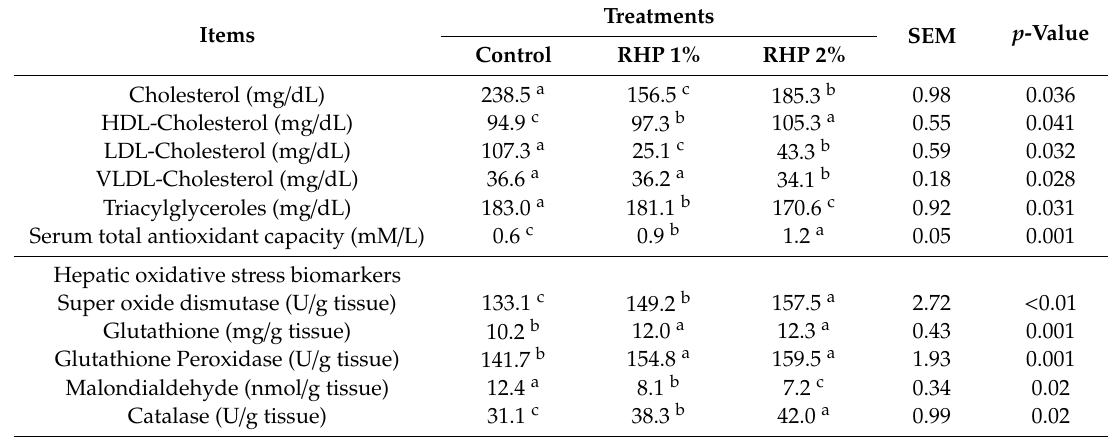
Table 5. Serum lipid profiles, total antioxidant capacity, and hepatic oxidative stress biomarkers of New Zealand white rabbits fed on 0, 1, or 2% red hot pepper for 8 weeks of treatments (n = 10 rabbits per